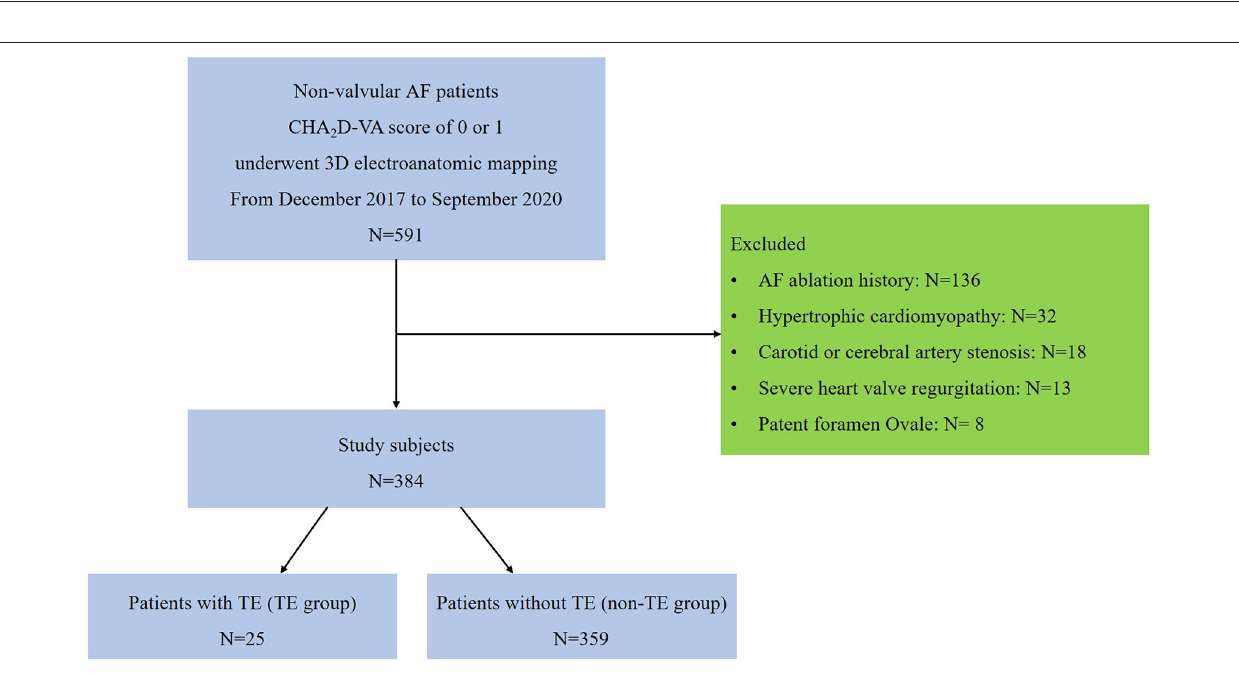
onset of the P wave in Lead II of the surface ECG to the earliest activation of the LAA during sinus